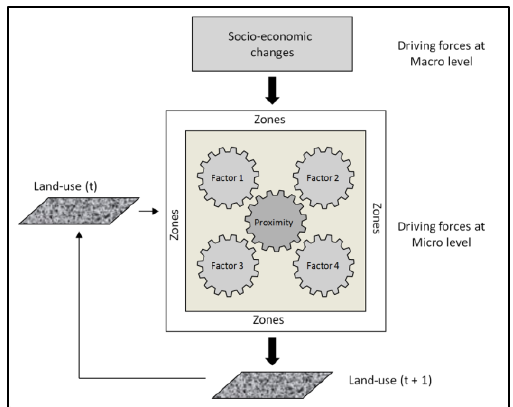
Figure 2. The dynamics within LUCIA